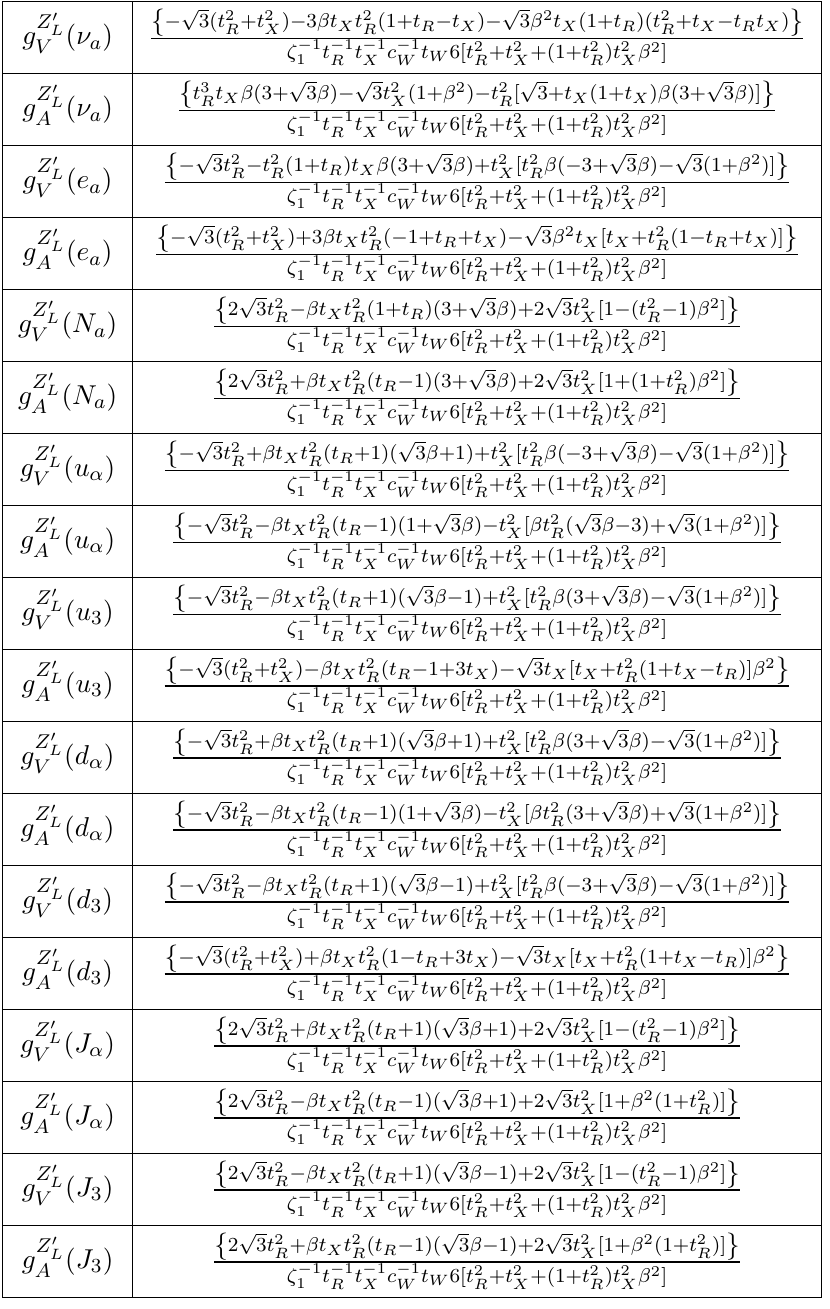
Table 3 . The couplings of Z 0